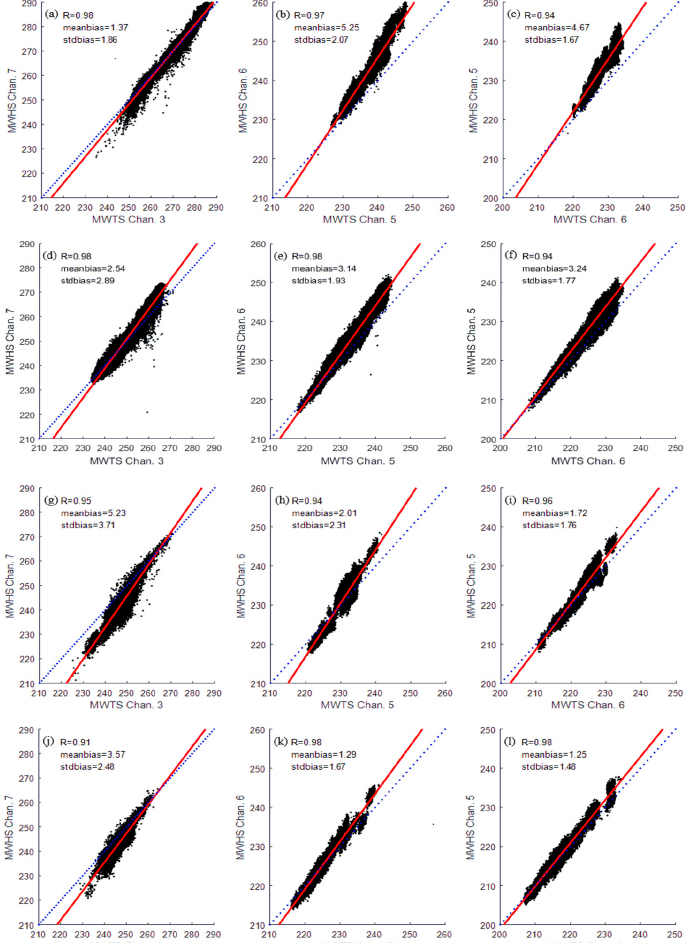
Figure 3. Scatter plots of the observed brightness temperatures after limb corrections for three sets of paired channels over four surface types (subfigures ( a–c ) for snow; ( d–f ) for land; ( g–i ) for sea and ( j–l ) for sea ice) under the clear sky. The subfigures ( a , d , g , i ) represent the scatter plots for CESI low , ( b , e , h , k ) for CESI mid and ( c , f , i , l ) for CESI high R represents the correlation